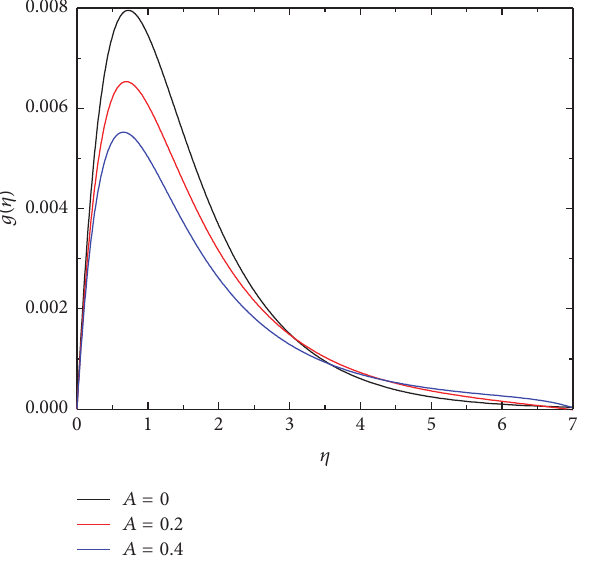
Figure 10: Microrotation profiles for various values of 𝐴 when 𝐾 = 0.2 , 𝑅 = 0.5 , and 𝜉 = 0 .